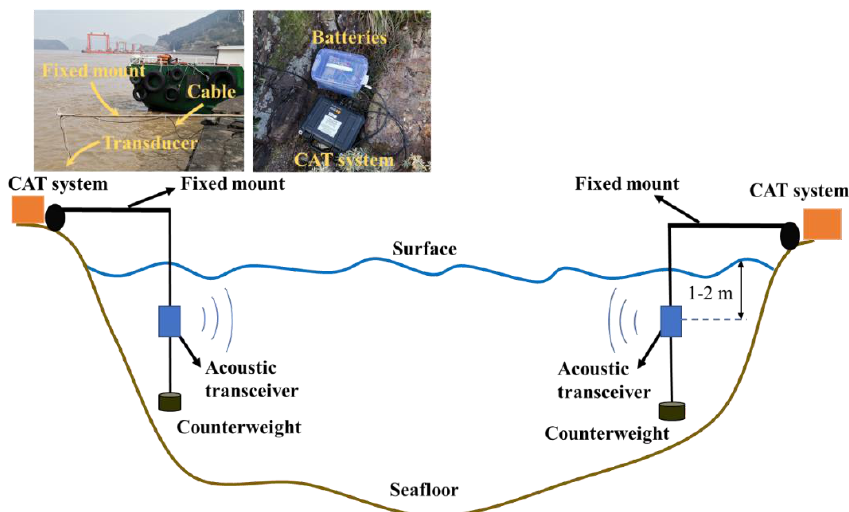
Figure 3. Experimental settings between the two stations; the acoustic transceivers were suspended down to 1–2 m under the surface with an additional weight by a fixed mount, coastal acoustic tomography (CAT) systems were synchronized with the GPS.